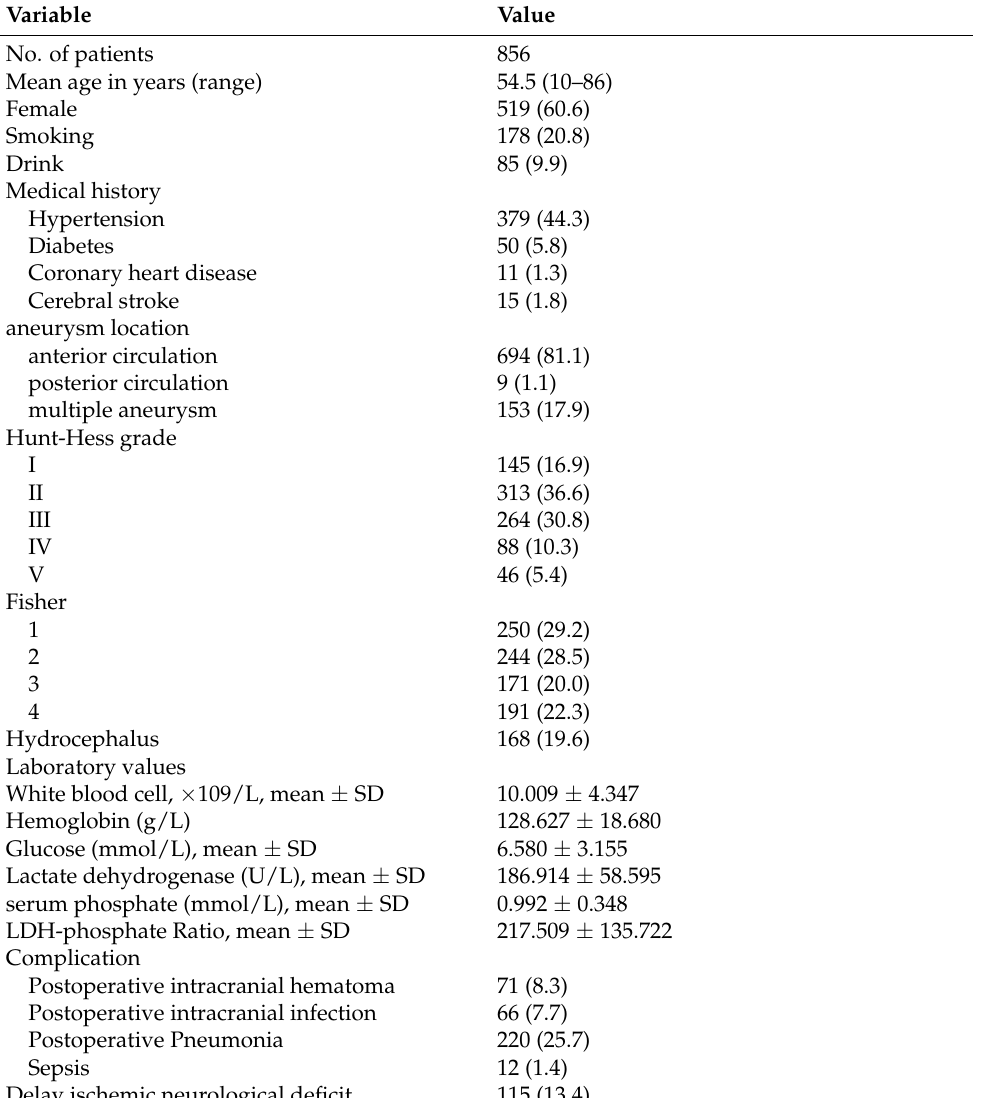
Table 1. Patient